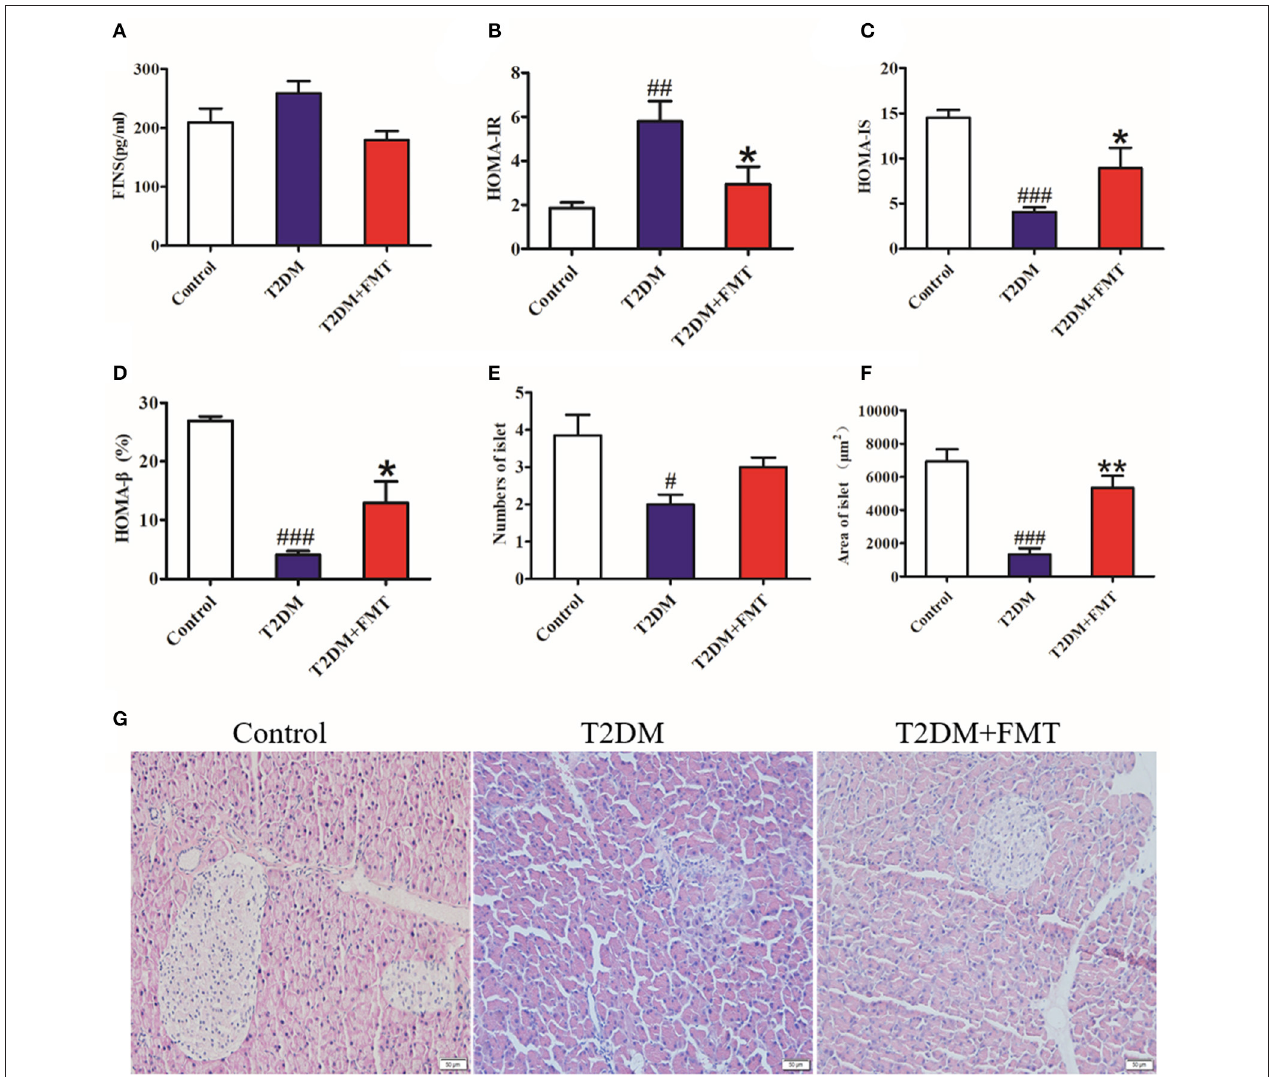
FIGURE 2 | The effect of FMT on insulin resistance and islet of the pancreas. (A) Fasting serum insulin level in different group. (B) HOMA-IR index in different group. HOMA-IR index = FBG × FINS/22.5 (C) HOMA-IS index in different group. HOMA-IS index = 1/HOMA-IR. (D) HOMA- β index in different group. HOMA- β index = 20 × FINS/(FBG-3.5) (%) (E) Relative amount of the islet in each group observed by HE staining image. (F) Relative area of the islet in each group observed by HE staining image. (G) Representative HE images of pancreas. * P < 0.05 vs. T2DM, ** P < 0.01 vs. T2DM, # P < 0.05 vs. Control, ## P < 0.01 vs. Control, ### P < 0.001 vs. Control, n =